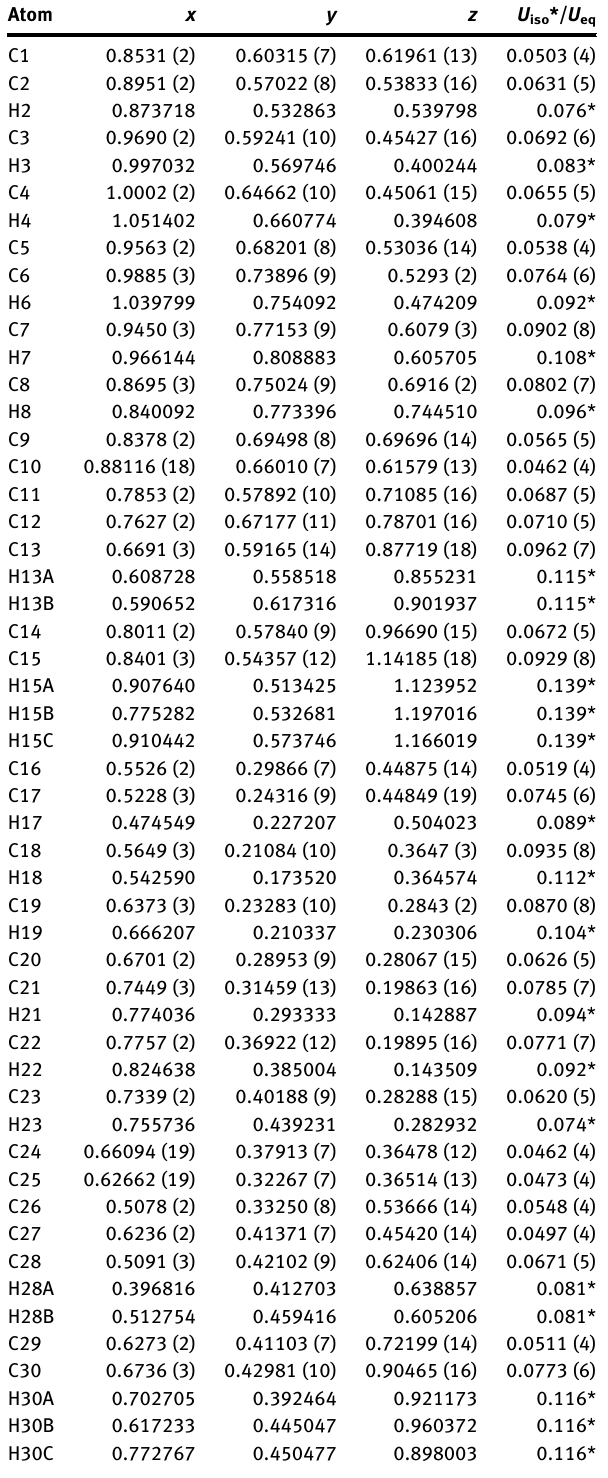
figure. The bond lengths of C14=O3, C29=O7, C11=O1, C12=O2, C26=O5 and C27=O6 in the title molecule are 1.181(2)